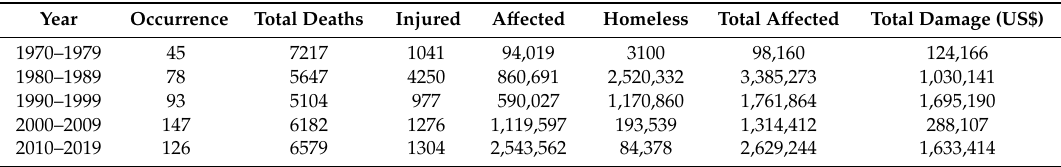
Table 1. Human and economic e ff ects due to landslides represented on a global scale (Data provided by EM-DAT: The Emergency Events Database, Universite catholique de Louvain-CRED, D. Guha-Sapir, www.emdat.be, Brussels, Belgium).